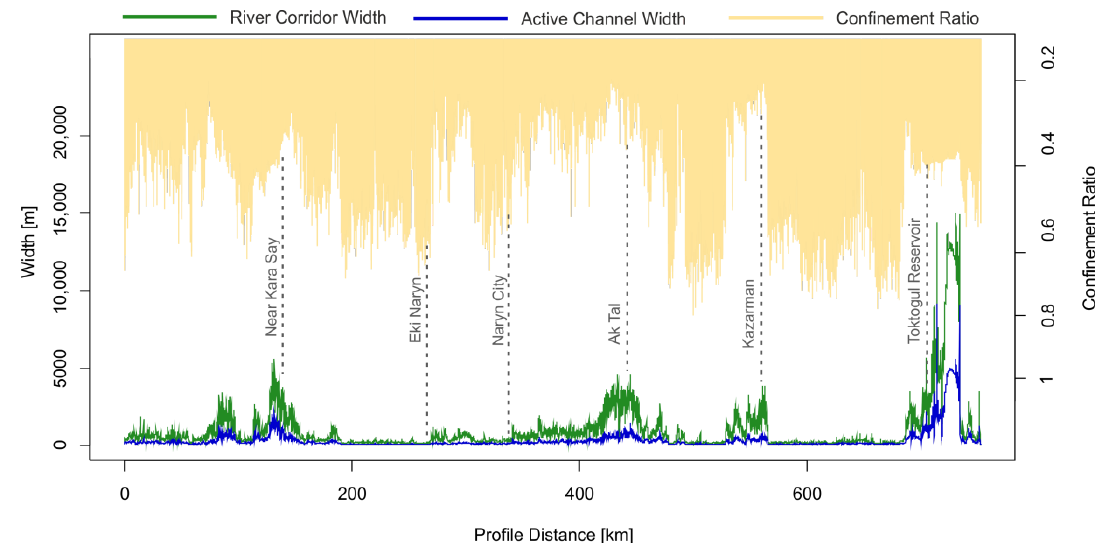
Figure 7. River corridor (green line) and active channel width (blue line); the confinement ratio is shown in